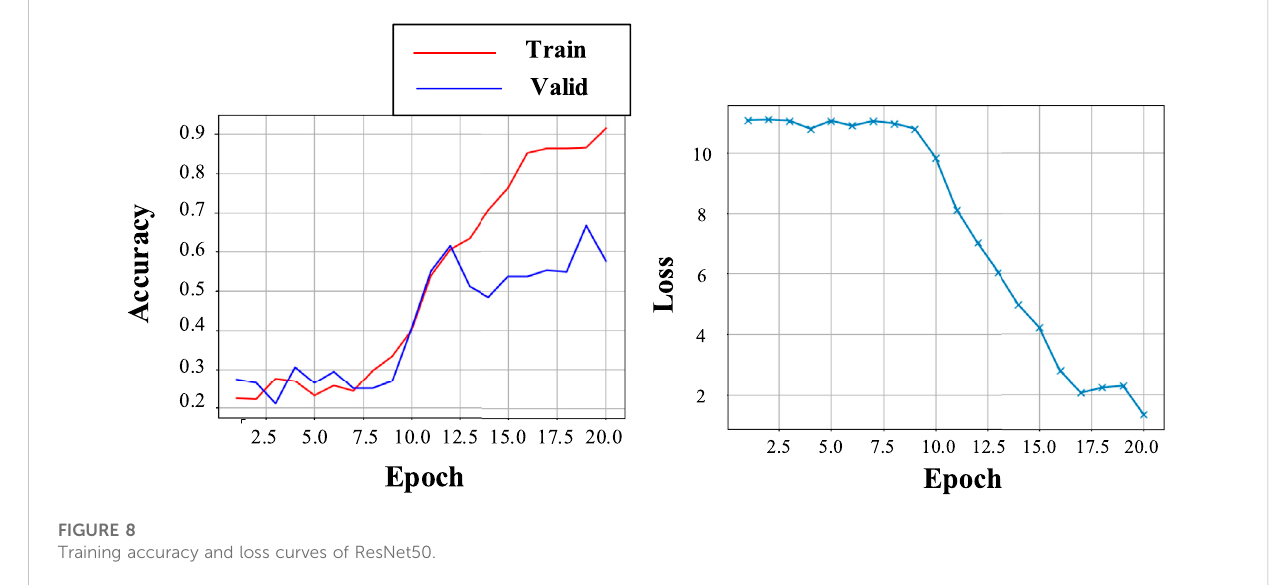
FIGURE 8 Training accuracy and loss curves of ResNet50.